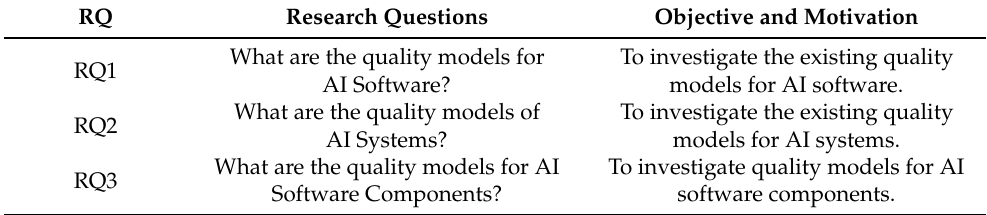
Table 2. Research Questions